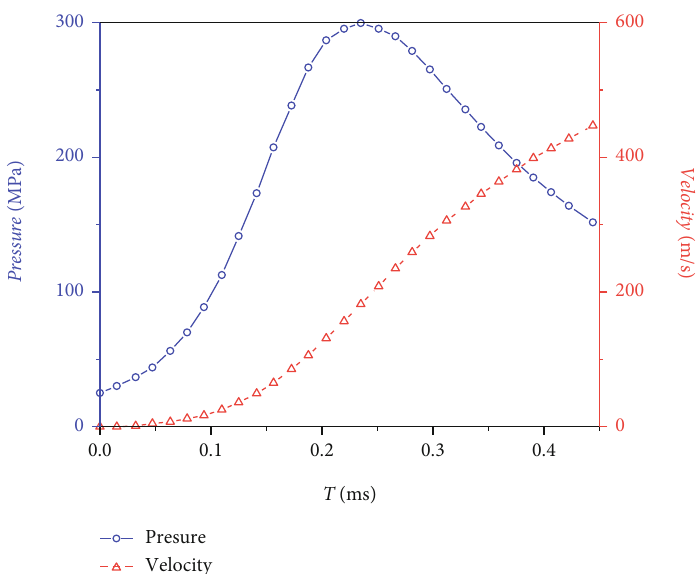
Figure 8: Time history curves for the chamber pressure and velocity. Table 9: Calculated and measured maximum chamber pressures.